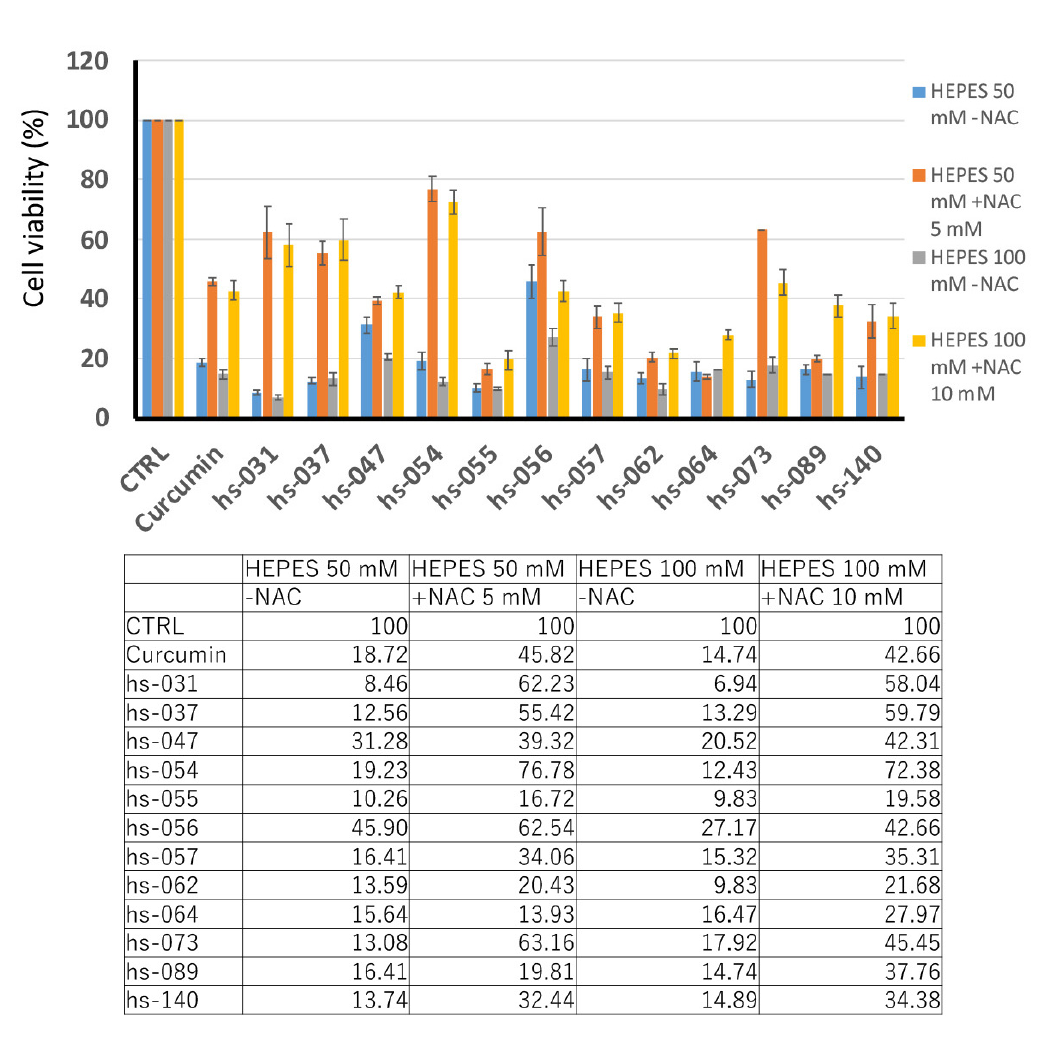
Figure 3. Growth inhibitory properties of curcumin derivatives. ( a ) K562 cells (5 × 10 5 cells / mL) were treated with curcumin derivatives (50 μ M) for 2 and 4 days, and subjected to the cell cycle analysis. ( b ) Cells treated as in ( a ) were subjected to SA- β -gal staining. ( c ) Cells treated with curcumin derivatives (50 µ M) for 1 h (lower panel), 24, 48, and 72 h (upper panel) were subjected to a ROS detection analysis using FACS. ( d ) Cells (3 × 10 5 cells / mL) were cultured in the presence of each compound (50 µ M) with and without NAC (5 mM and 10 mM) for 2 days, and viable cells were counted using the trypan blue staining method. HEPES bu ff er was supplemented to avoid a change in pH. ( a – d ) The results are the averages of three independent experiments (means ± SD).